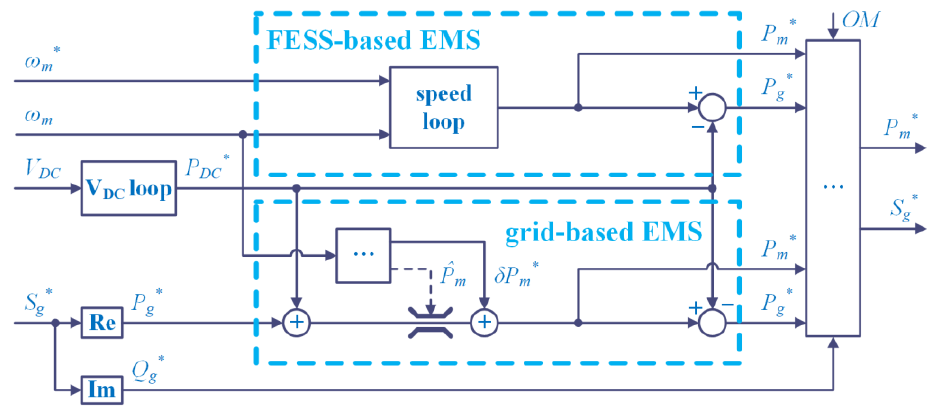
Figure 3. The EMS equivalent block scheme proposed for the FESS.